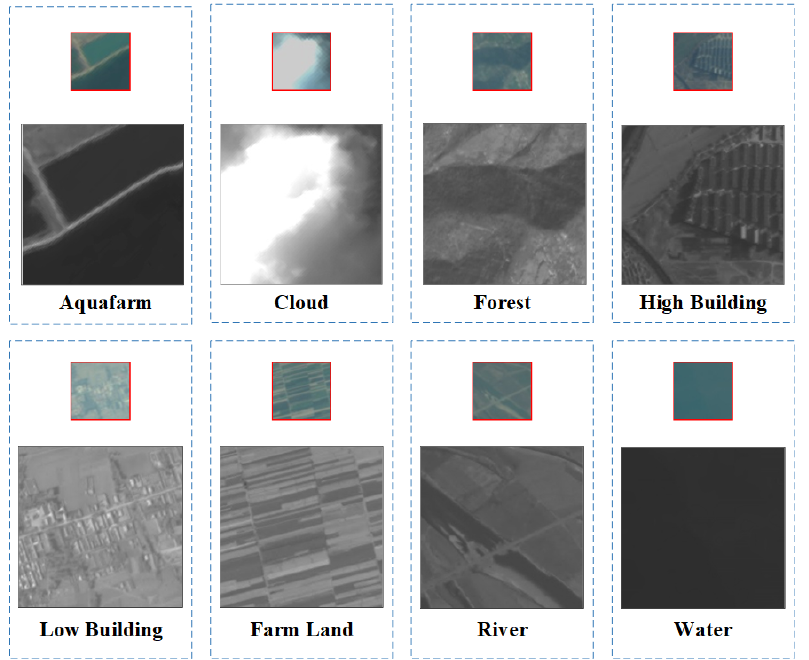
Figure 3. Examples of the DSRSID. The upper example in each block is an MSP image, and the lower sample is a PAN